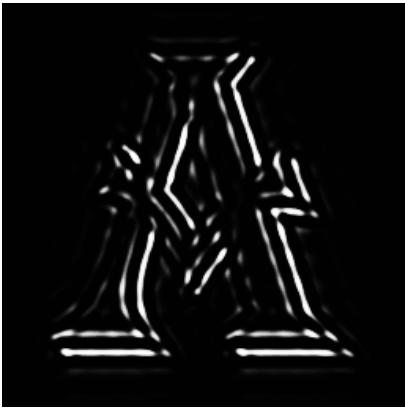
Figure 3. Image reconstruction using Curvelet coefficients of one single scale.